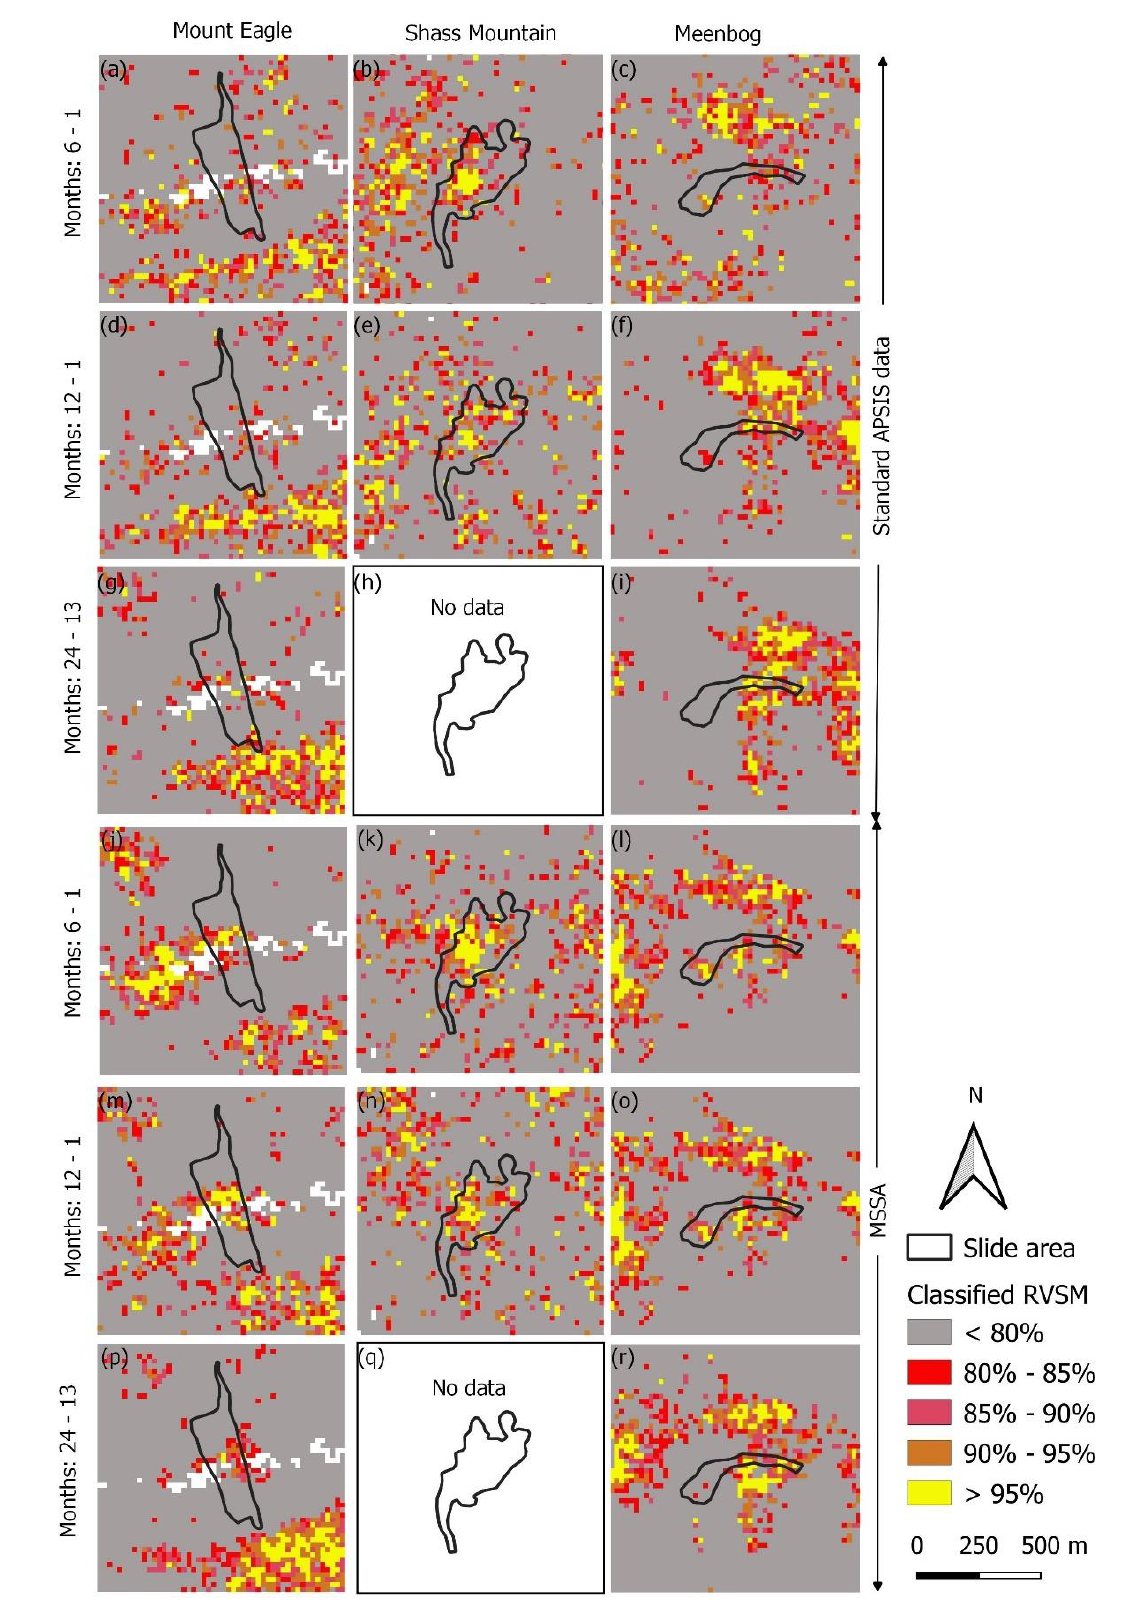
Figure 4. RVSM for the three slide sites shown as percentiles, for standard APSIS (a–i) and MSSA (j–r) data, for the six (a–c, j–l) and twelve (d–f, m–o) month periods immediately preceding the slide, and for the twelve month period (g–i, p–r) ending one year ahead of the slide. White areas indicate no